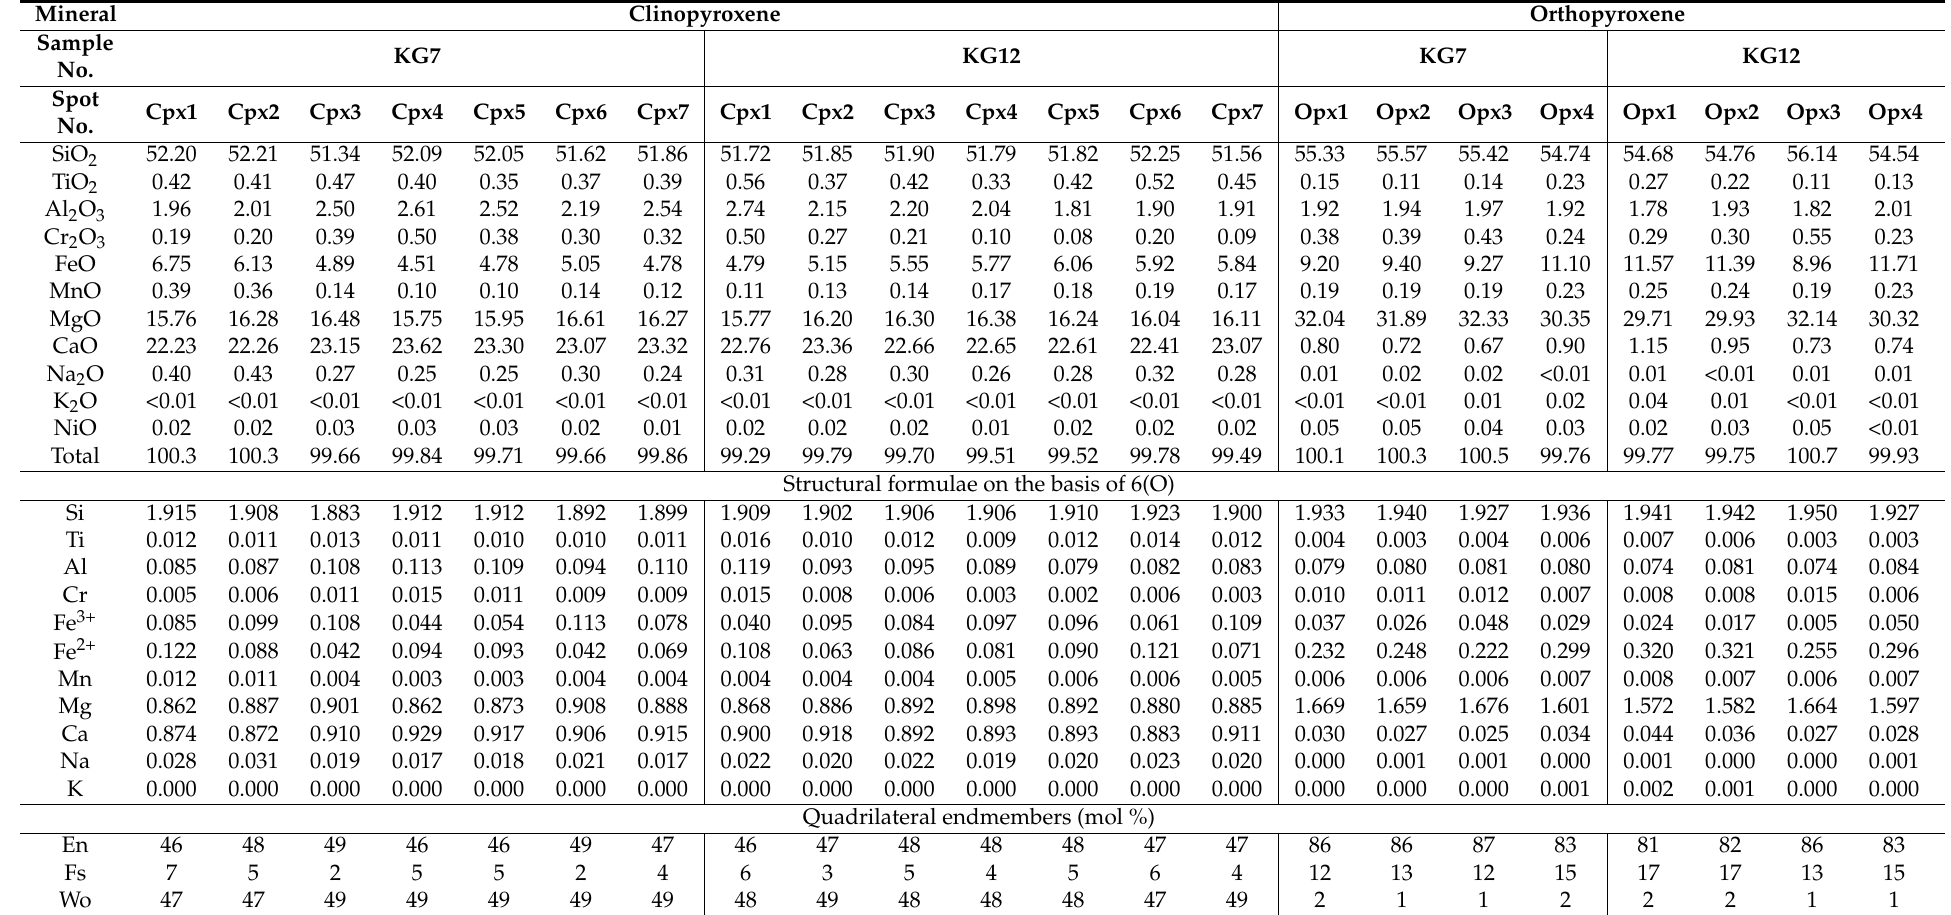
Table 2. Microprobe analyses of clinopyroxene and orthopyroxene in the olivine gabbro of the Khamal mafic